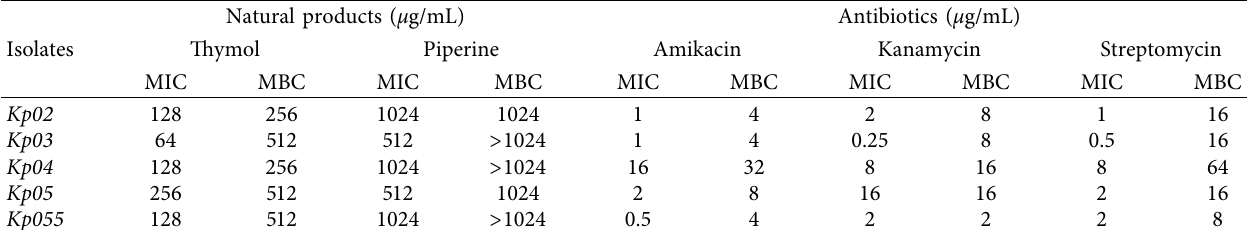
Table 1: Susceptibility of K. pneumoniae planktonic cells against thymol, piperine, and antibiotics. Isolates